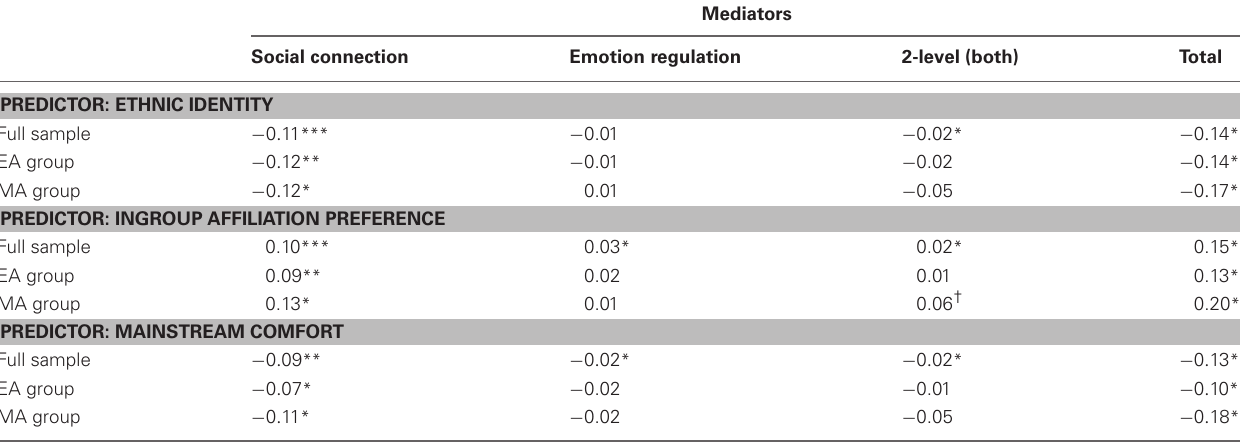
Table 6 | Standardized path coefficient estimates for model 3 indirect effects on anxiety